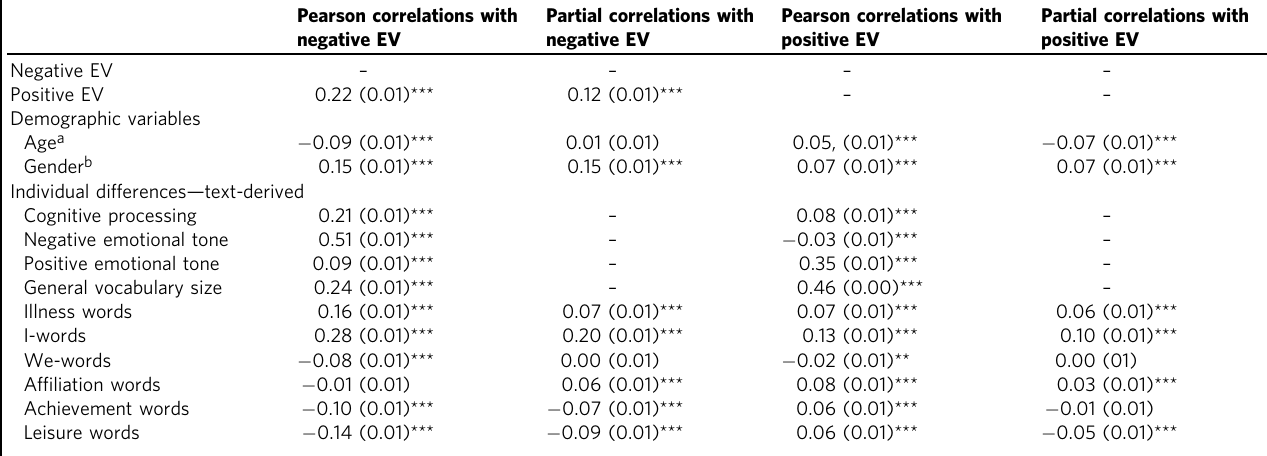
Table 3 Pearson correlations of emotion vocabulary (EV) with other study variables for study 2 ( N = 35,385).